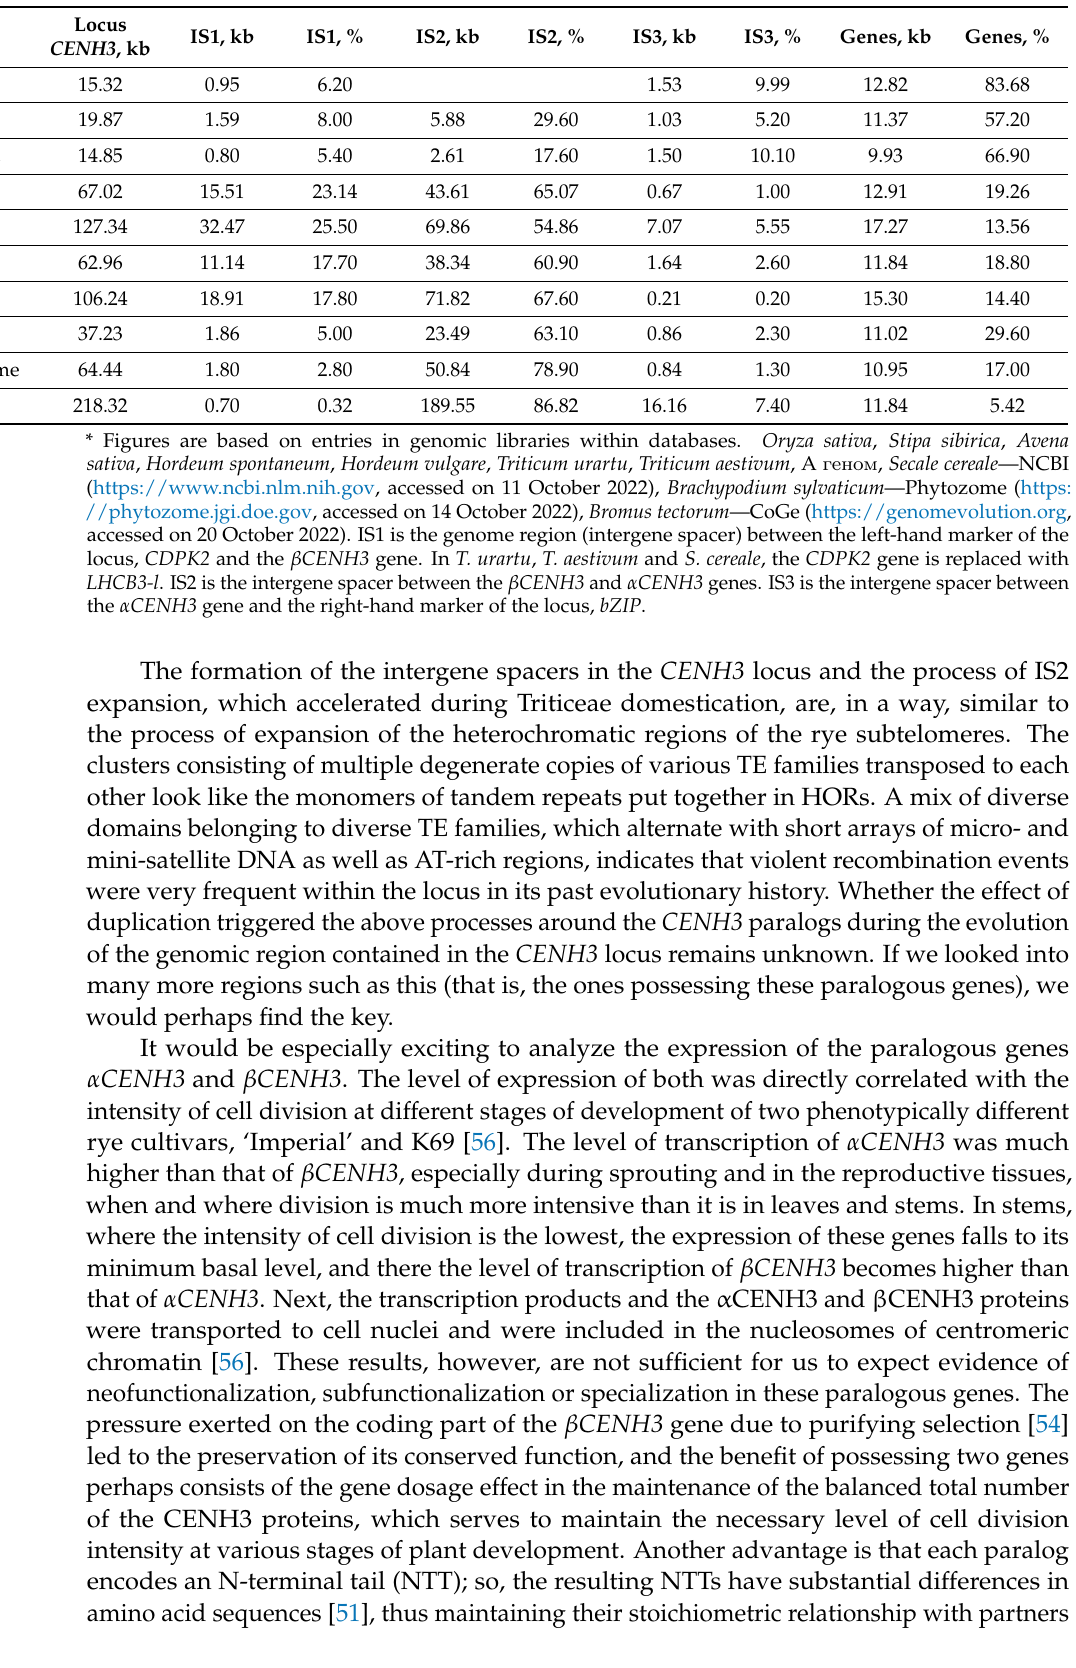
Table 1. Size of the CENH3 locus and its structural elements (genes and intergene spacers, ISs) in various cereal genomes